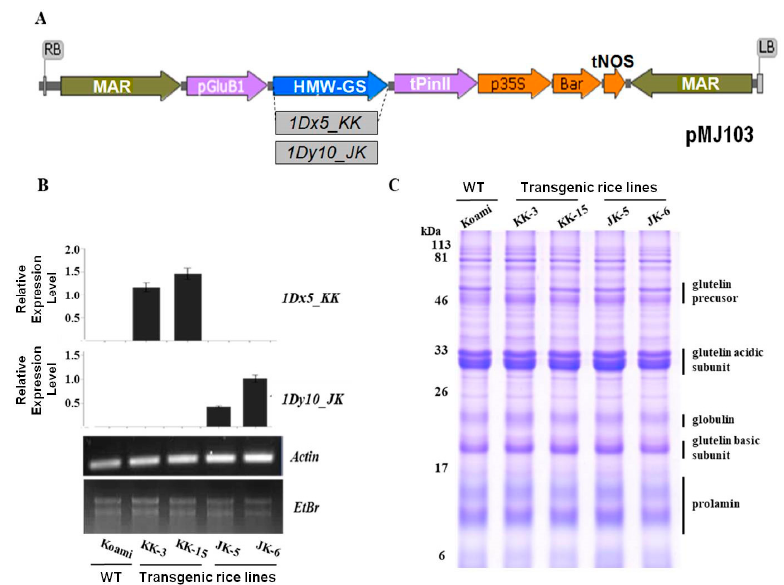
Figure 2. Binary vector construction and generation of transgenic rice plants expressing wheat high-molecular-weight glutenin subunits (HMW-GSs) 1Dx5_KK and 1Dy10_JK. ( A ) Binary vector used to generate transgenic rice plants expressing wheat HMW-GSs 1Dx5_KK and 1Dy10_JK. The pMJ vector has a Glu-B1 promoter, Bialaphos resistance ( Bar ) gene as herbicide-resistance marker, and Nopaline synthase terminator ( tNOS ); ( B ) Transcript level analysis of 1Dx5_KK and 1Dy10_JK genes in seeds of independent KK and JK transgenic rice lines, respectively, using quantitative real-time PCR; and, ( C ) Expression analysis of rice total seed storage proteins (SSPs) in mature seeds of Koami (wild-type) and independent transgenic rice lines. Total SSPs (10 μ g) were separated using SDS-PAGE (12.5%) and visualized using Coomassie brilliant blue (CBB) staining. WT, wild type; KK and JK, transgenic lines expressing 1Dx5_KK and 1Dy10_JK, respectively.